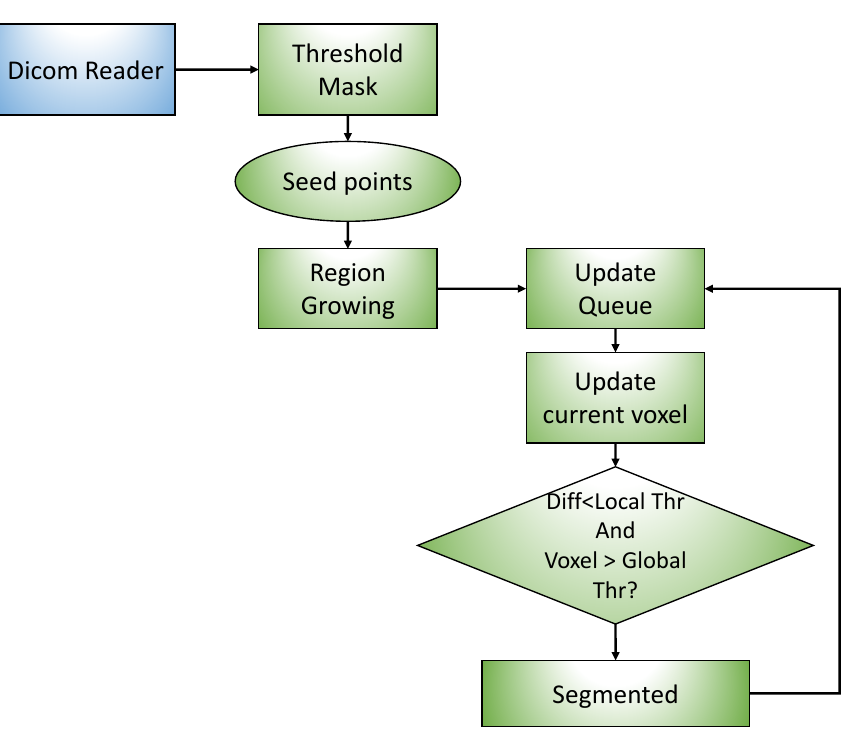
Figure 1. Overview of the bone segmentation algorithm.